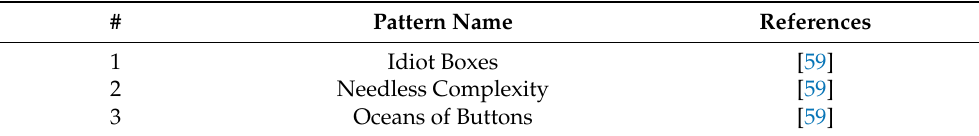
Table 8. Anti-patterns MUIDPs.